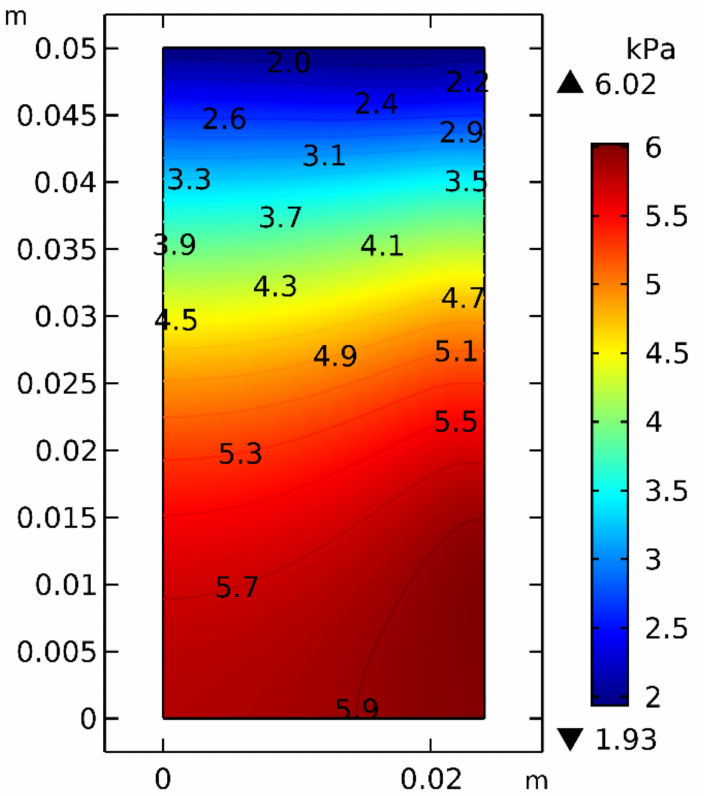
Figure 5. Pressure distribution inside the reactor at minute 25 (local temperature maximum) for